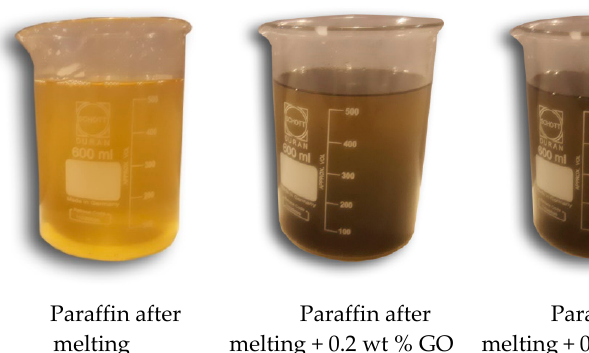
Figure 3. Steps of preparation of paraffin/graphene oxide.